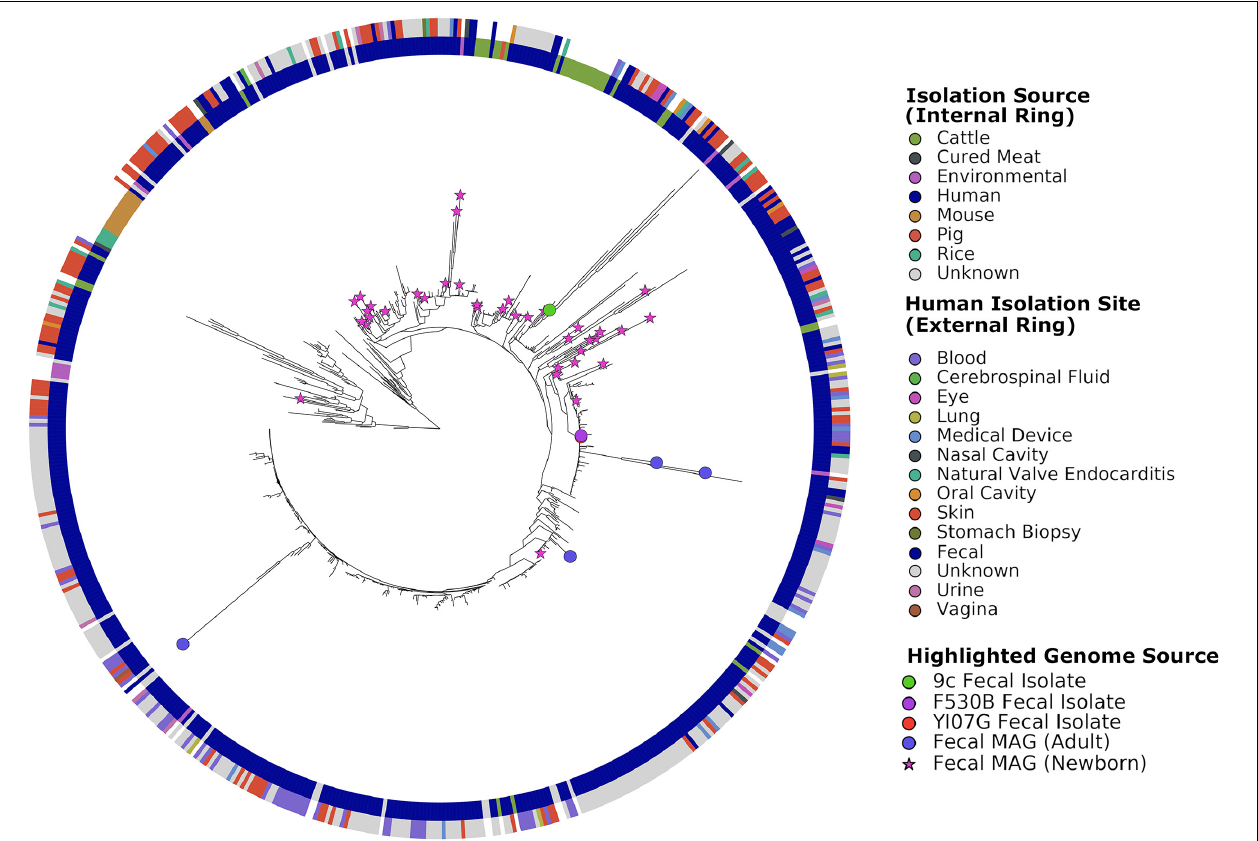
FIGURE 1 | Phylogenetic tree of all genomes used in this study constructed using PhyloPhlAn. Leaves representing fecal-associated genomes are highlighted on the tree, reference genomes and MAGs of non-fecal origin are not highlighted for readability. The inner ring shows the source of the isolated genomes or samples from which MAGs were recovered. The outer ring shows the body site from which the genome or MAG was isolated or